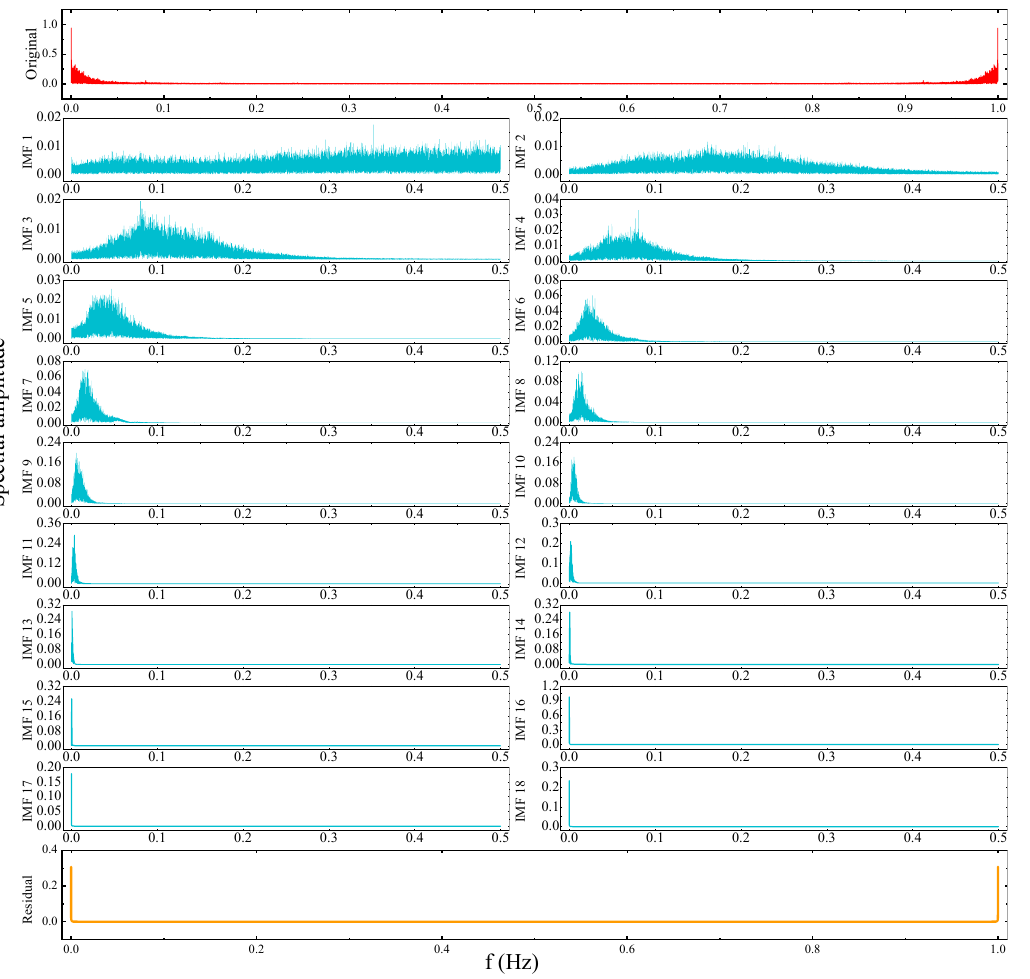
Figure 10. Comparison of ShiDao effective data in the frequency domain for the IMFs component of SWH sequence by EMD algorithm.